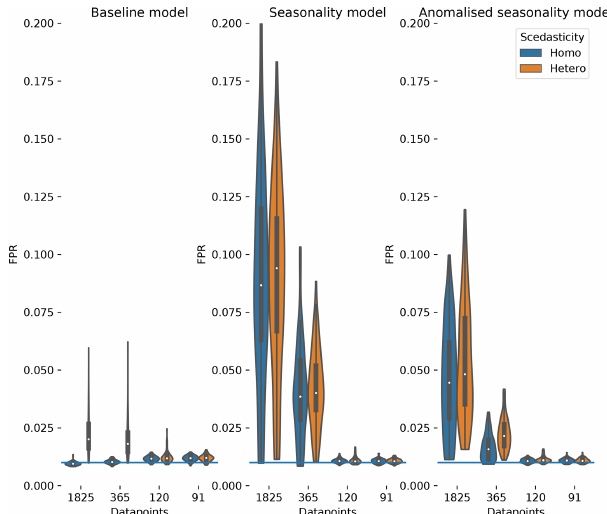
Figure 2. The distribution of false positive detection rates estimated for the baseline dataset, the seasonality dataset and the anomalised seasonality dataset (mean seasonal cycle subtracted). The distribu- tions are given for different time series length (number of data- points). Additionally, the distributions are split to show the impact of heteroscedastic noise (orange) compared to normal distributed noise (blue). The significance level of 0.01 is given by a blue hori- zontal